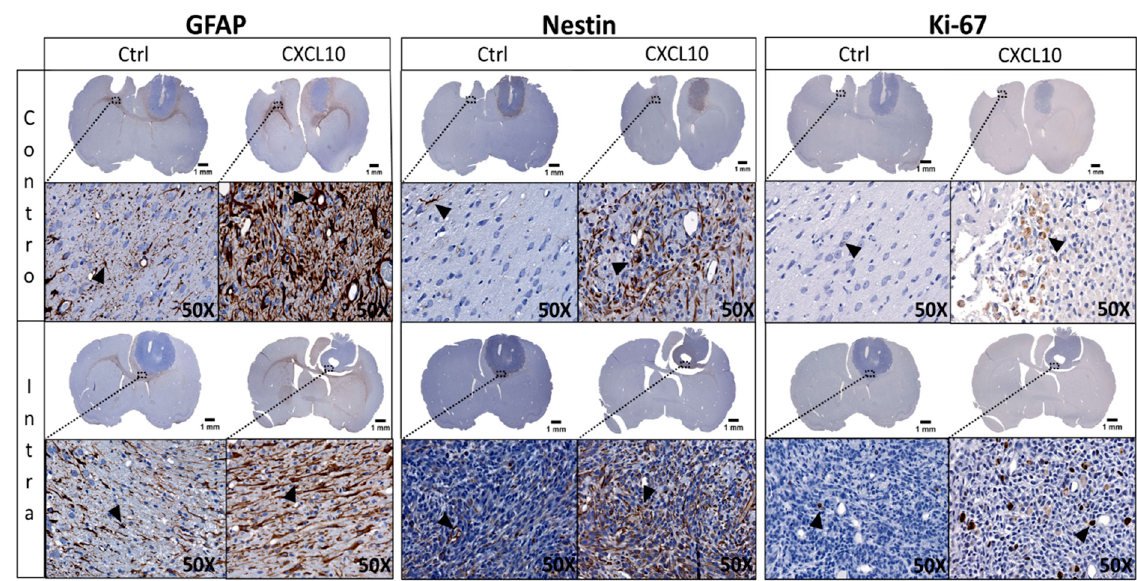
Figure 4. Brain immunohistology (GFAP, nestin and Ki-67) of F98 glioma bearing rats for the hemisphere having received GlioGel with or without chemoattractant. GlioGel implanted into the controlateral (Contro) or intratumoral (Intra) hemi- sphere without chemoattractant (Ctrl) or with CXCL10 chemoattractant. Immunohistochemical staining appear in brown (examples are pointed by the black arrowheads).